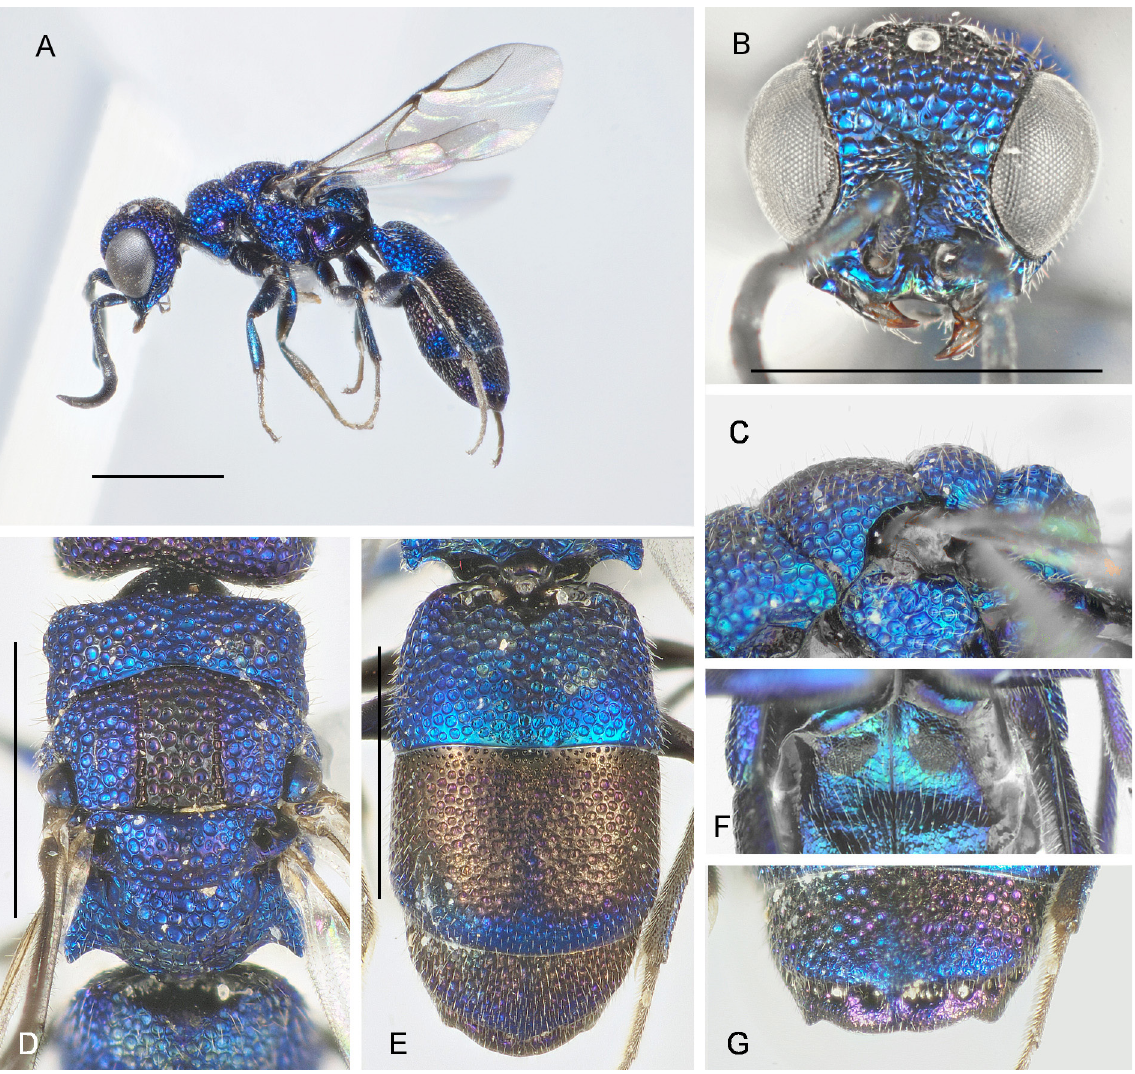
Fig. 8. Chrysidea rioae sp. nov., holotype, ♂. A . Lateral habitus. B . Head. C . Mesoscutum, mesoscutellum and metanotum in lateral view. D . Mesosoma. E . Metasoma. F . Black spots on S2. G . T3. Scale bars = 1.0